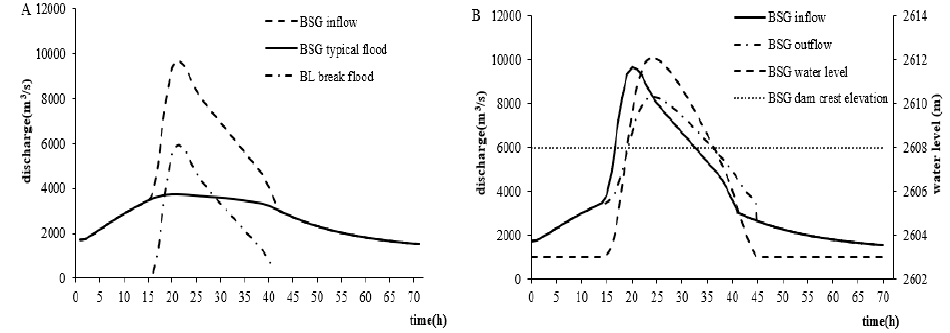
Figure 16. ( A ) The BL break flood encounters BSG typical flood; ( B ) the regulated flood progress of BSG.